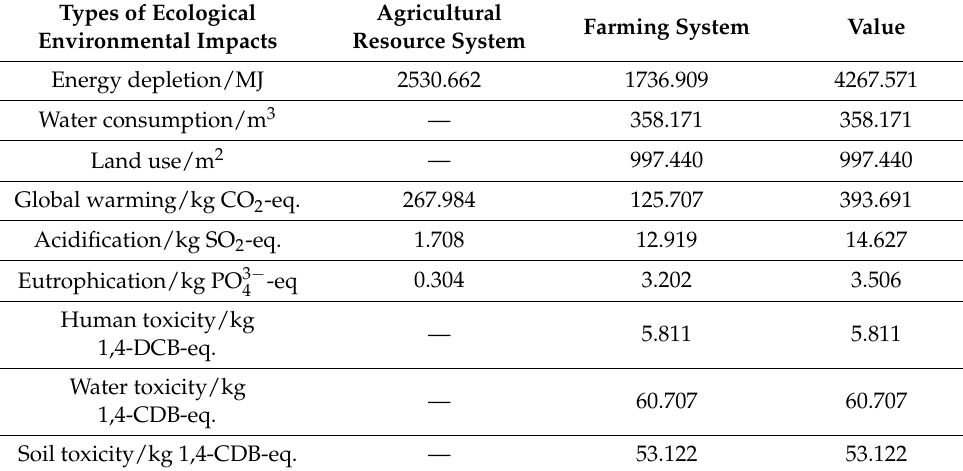
Table 4. Potential ecological environmental impacts throughout the rice life cycle. Types of